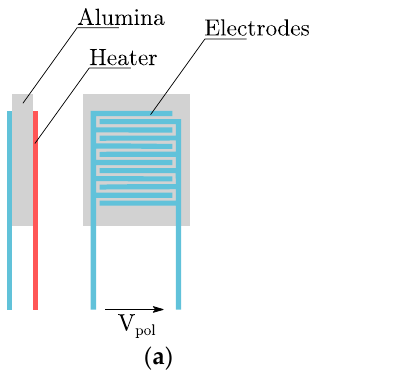
Figure 3. ( a ) Illustration of the resistive soot sensor; ( b ) Typical scanning electron microscopy of